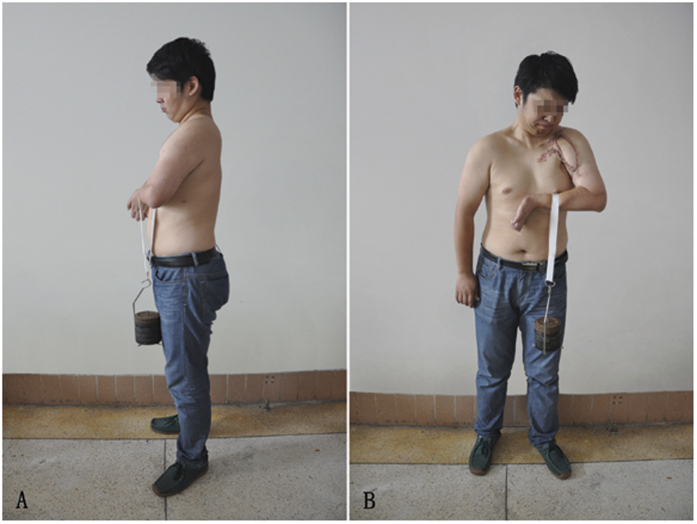
This patient came to our hospital with a global BPI after a motorcycle accident and primary nerve surgery failed.Transfer of gracilis reinnervated with accessory nerve. He can lifted a 5kg weight at the final follow-up (63 months). (A) Lateral view (B). Frontal view.